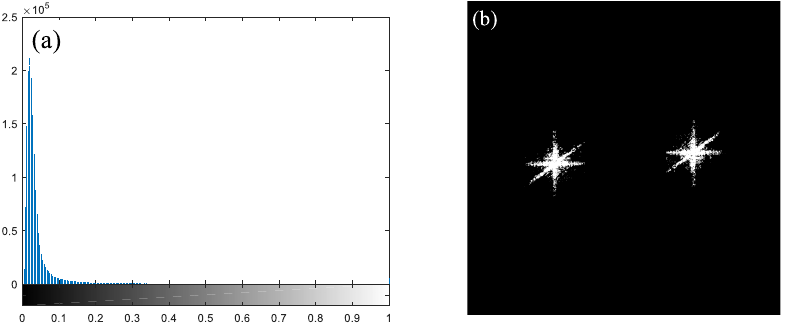
Figure 4. ( a ) Gray histogram of the low-frequency component; ( b ) binary image of the low-frequency component.